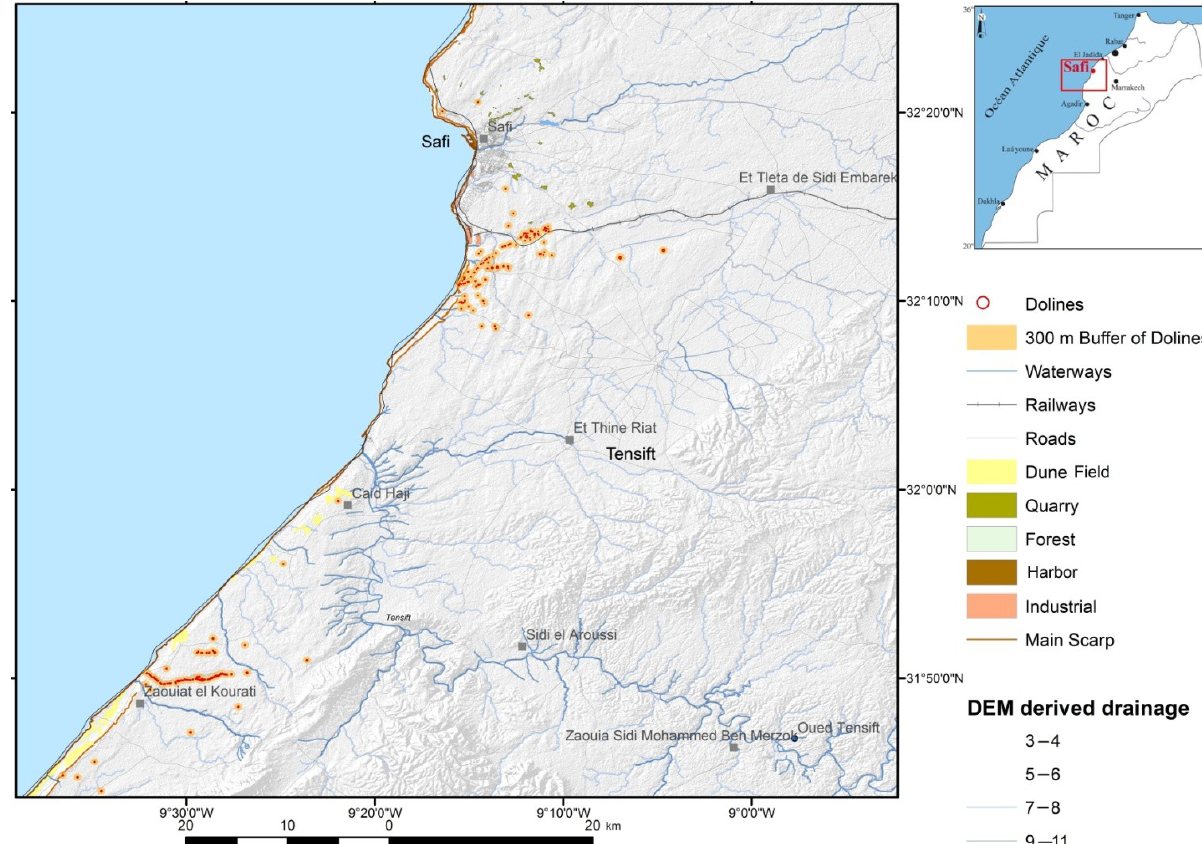
Figure 1. The position of the study area in Northwest